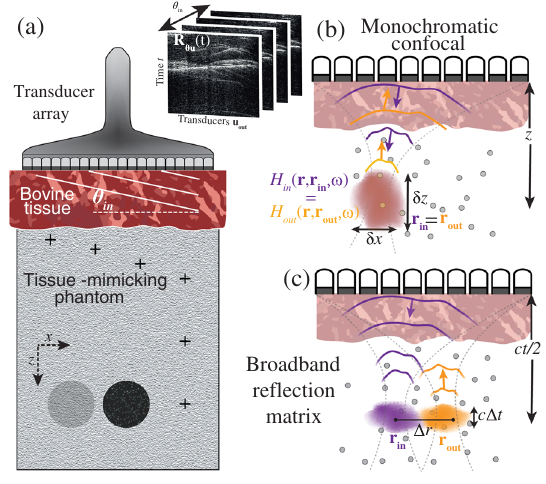
FIG. 1. Principle of the focused reflection matrix approach. (a) Sketch of the experimental setup for the acquisition of R u θ ð t Þ . An ultrasonic transducer array is in direct contact with a layer of bovine tissue placed on the top of a tissue-mimicking phantom. R ð t Þ is acquired by recording the time-dependent reflected u θ field at each transducer element u out , for each plane-wave illumination θ . (b) Each pixel of a conventional image results in from confocal beam forming applied to R u θ in emission and reception. (c) Matrix imaging consists of performing focused beam forming to probe distinct points r in and r out in emission and reception. The set of impulse responses between such virtual transducers form a focused reflection matrix R xx at each